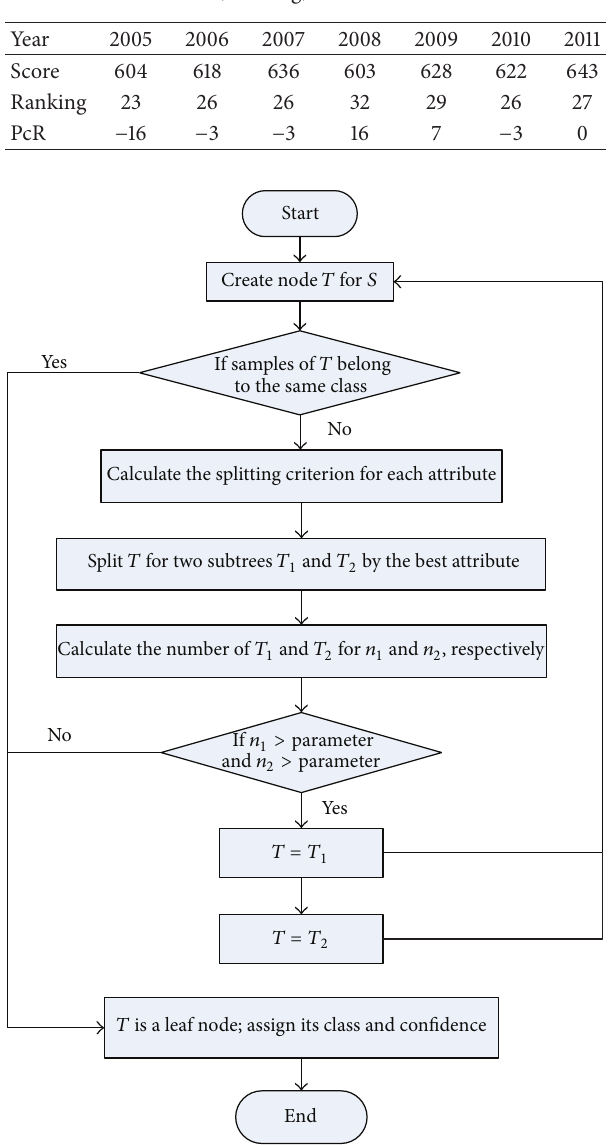
Figure 1: Decision tree construction flow